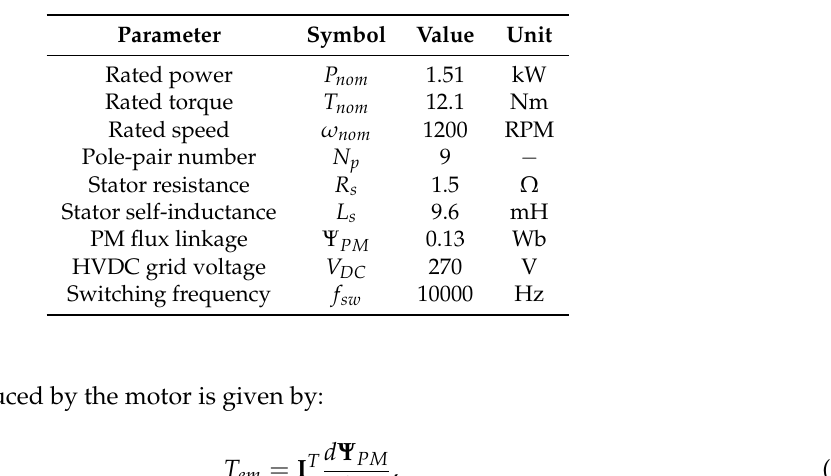
Table 7. Most significant parameters of the simulated